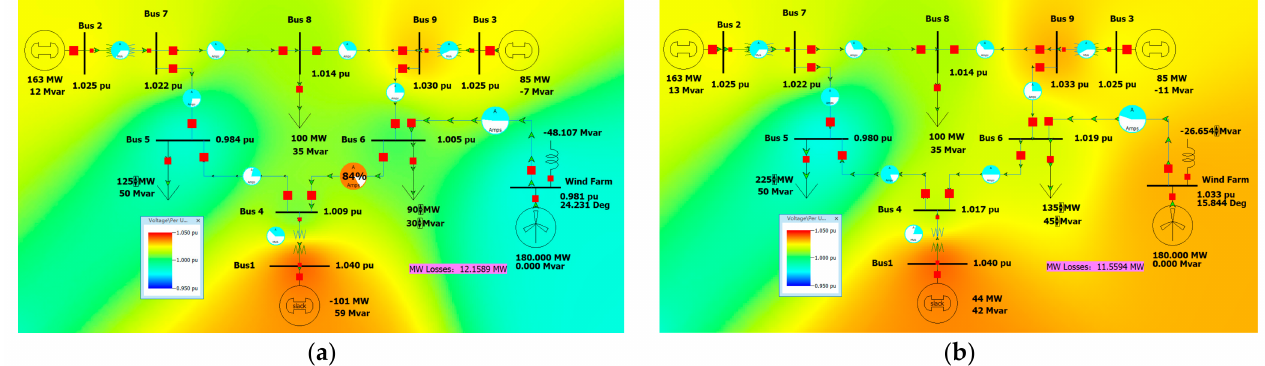
Figure 5. Simulation results when tower A is connected to bus 6 (300 km) after adding inductance. ( a ) The results under the minimum load condition and ( b ) the results under the maximum load condition. (2)